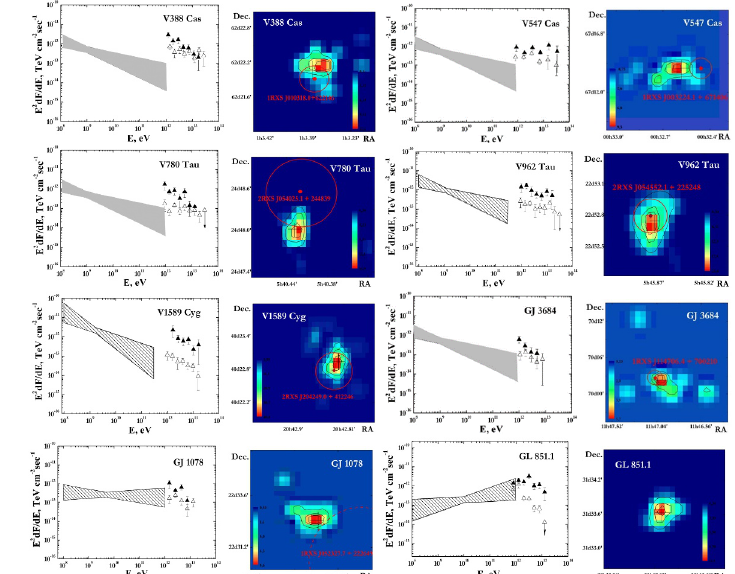
Figure 2. SEDs of red dwarfs by SHALON and Fermi LAT; Emission maps of red dwarfs by SHALON. that the value of exponent γ may change if one or several such stellar objects are at the distances of several pc from the